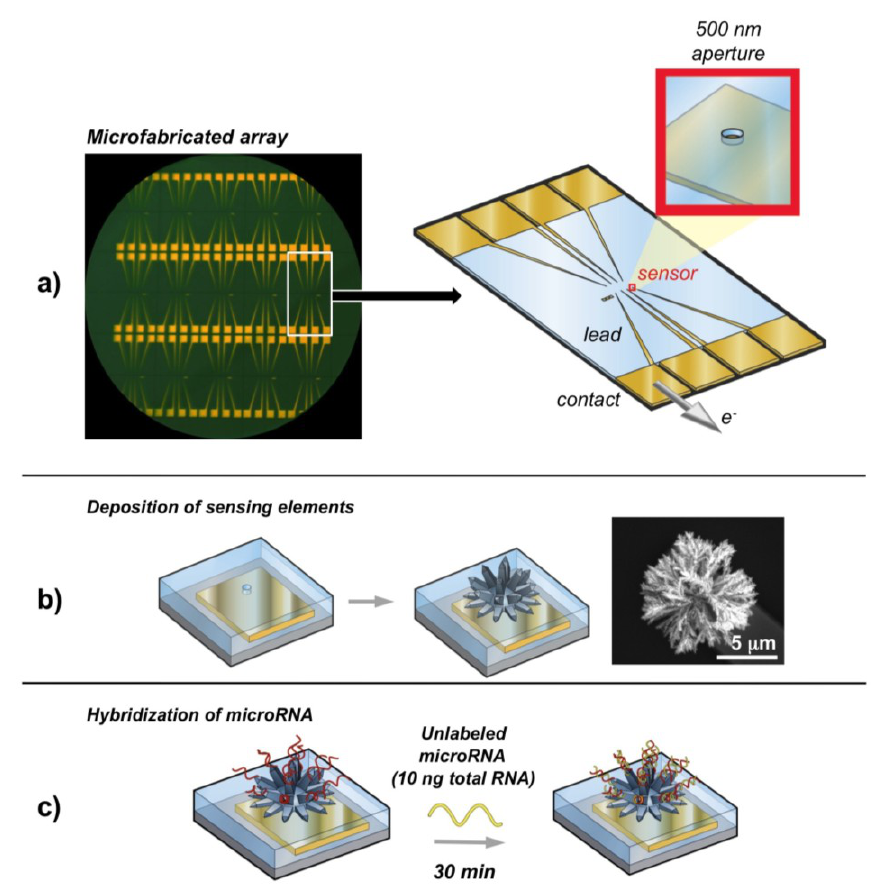
Figure 9. Electronic microRNAs detection with nanostructured microelectrode (NME) chips. ( a ) Photograph ( left ) showing microfabricated chips that feature 500 nm openings for the electrochemical deposition of NMEs, and illustration ( right ) of the chip structure; ( b ) Schematic illustration of the generation of sensing elements by palladium